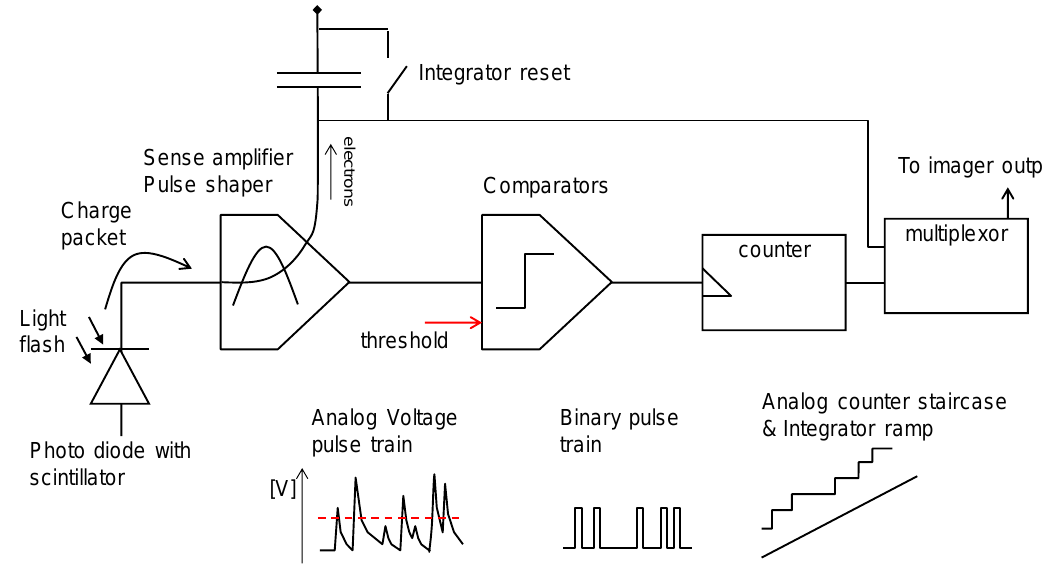
Figure 17. Overall pixel topology allowing simultaneous photon counting and charge integration.